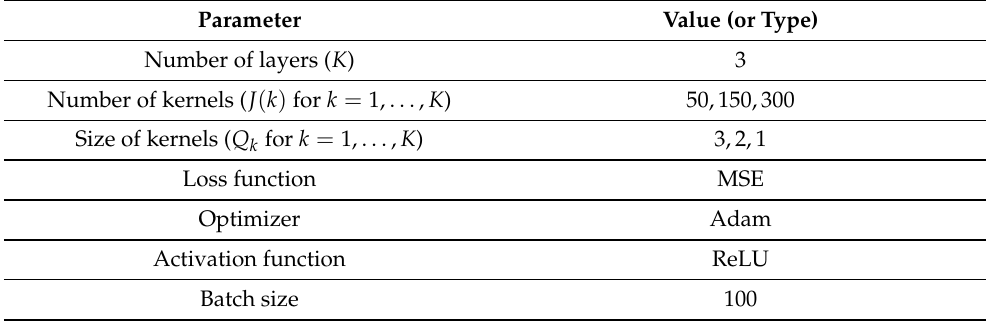
Table 2. Parameter setting for CNN structure.